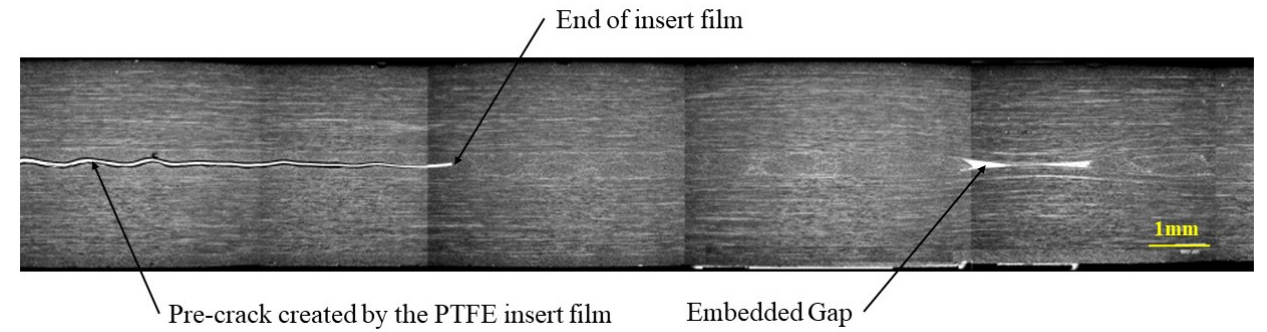
Figure 3. Microstructural SEM observation of a specimen containing embedded defect used for delamination tests—Gap 6.35 mm with caul plate.